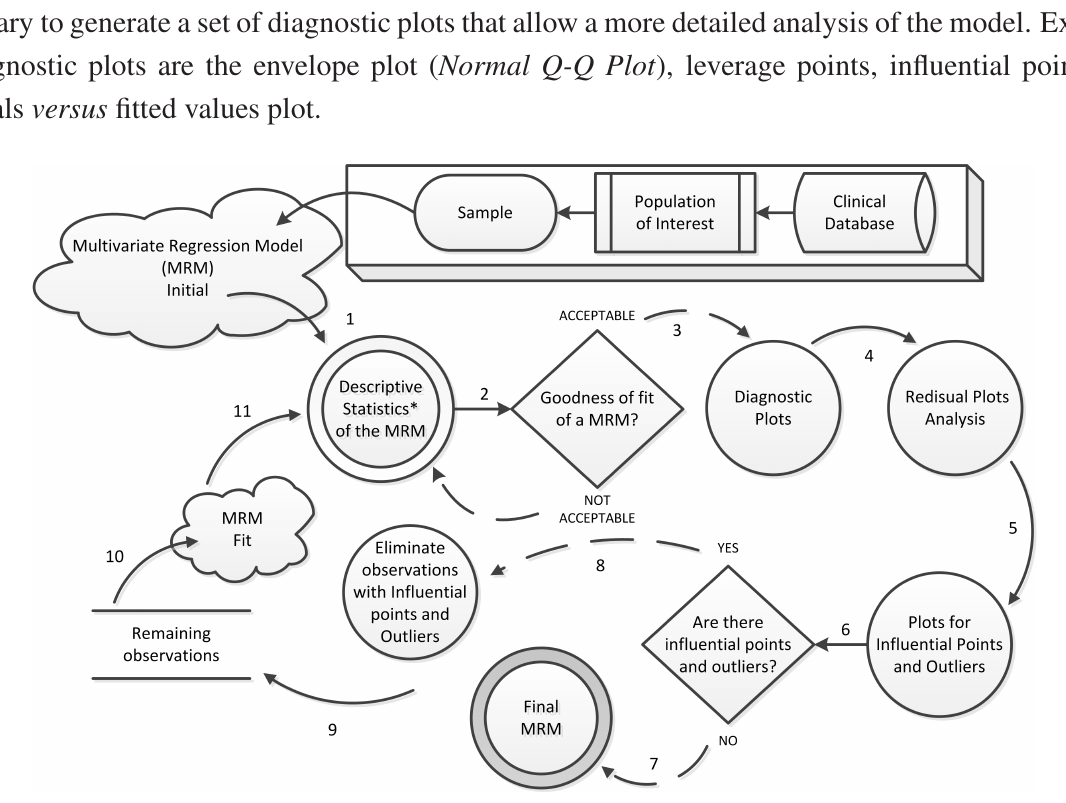
Figure 2. The Fit Process of the Multivariate Regression Model for Each Vital Sign of